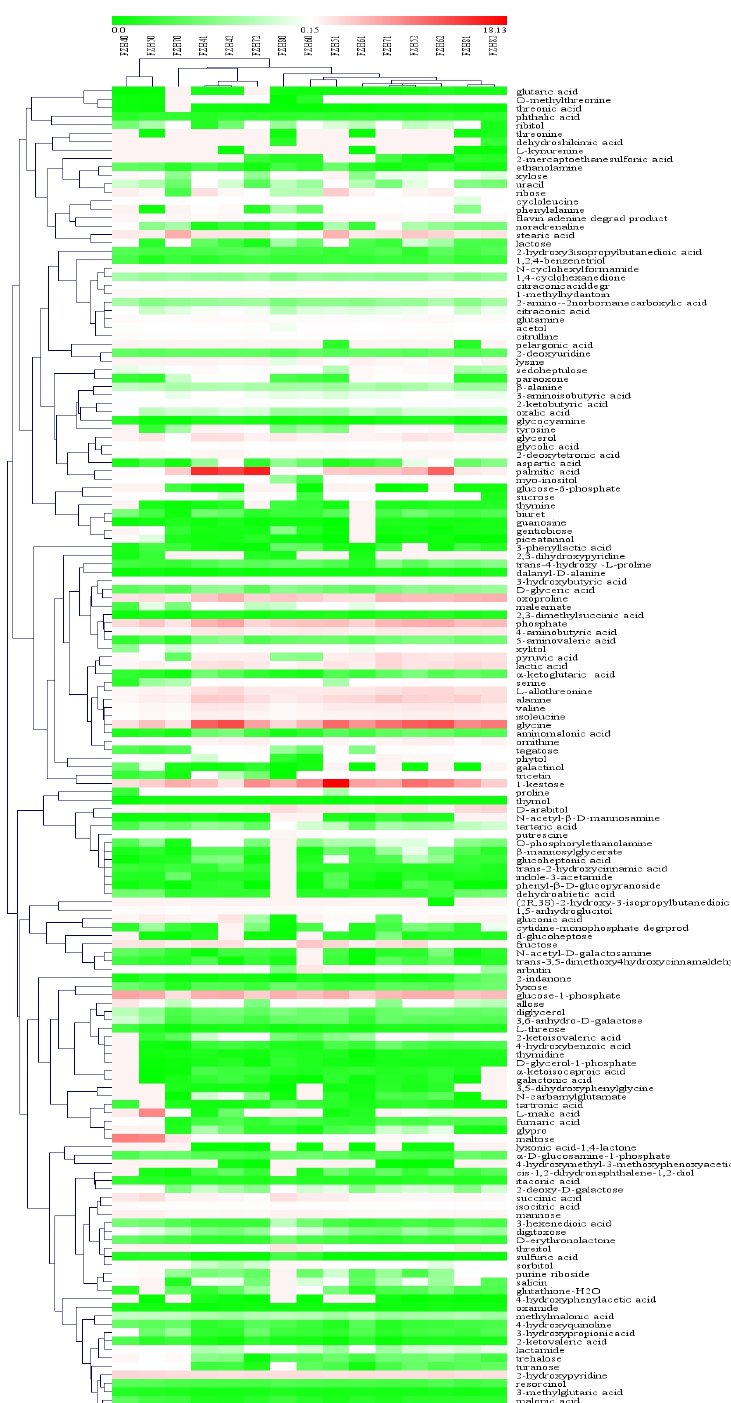
Figure 4. Heatmap and hierarchical cluster analysis for the 157 metabolites discovered in the fermen- tation broth of Epichloë sinensis . FZH40, FZH41 and FZH42 represent the treated 4-week fermentation broth samples in the presence of 0, 0.1 or 0.2 mmol/L Na 2 SeO 3 , respectively. FZH50, FZH51 and FZH52 represent the treated 5-week fermentation broth samples in the presence of 0, 0.1 or 0.2 mmol/L Na 2 SeO 3 , respectively. FZH60, FZH61 and FZH62 represent the treated 6-week fermentation broth samples in the presence of 0, 0.1 or 0.2 mmol/L Na 2 SeO 3 , respectively. FZH70, FZH71 and FZH72 represent the treated 7-week fermentation broth samples in the presence of 0, 0.1 or 0.2 mmol/L Na 2 SeO 3 , respectively. FZH80, FZH81 and FZH82 represent the treated 8-week fermentation broth samples in the presence of 0, 0.1 or 0.2 mmol/L Na 2 SeO 3 ,